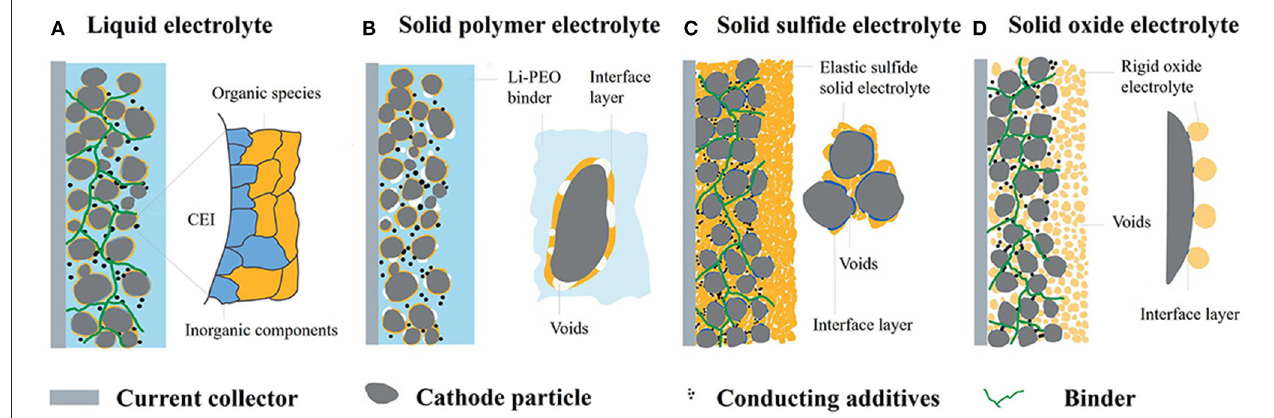
FIGURE 2 | Models of morphology at the interface between cathode-electrolyte: (A) The cathode particles are totally immersed in a liquid electrolyte and an interface layer will form. (B) Cathode particles are distributed in a Li-PEO binder with good contact while voids will generate upon cycling because of the interfacial reactions or pulverization of cathode particles. (C) Sulfide particles have favorable mechanical properties as ductility and deformability, which could change its shape to match with the rigid solid electrode. (D) Solid oxide electrolyte: Poor point-contact will form due to the rigid ceramic nature. Interface layer will form in all the aforementioned system if decomposition reactions or interdiffusion occurred at the